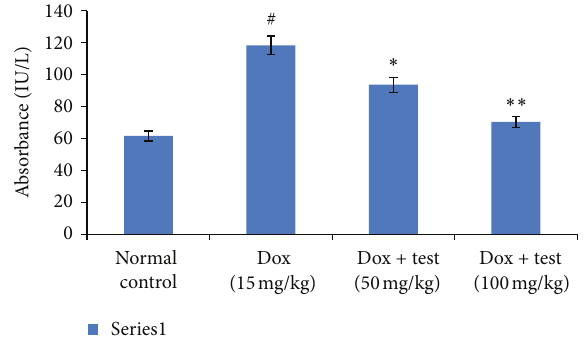
Figure 4: Effect of test compound on plasma AST levels in rats treated with doxorubicin. # 𝑃 < 0.001 versus normal control; ∗ 𝑃 < 0.05 versus dox, ∗∗ 𝑃 < 0.01 versus